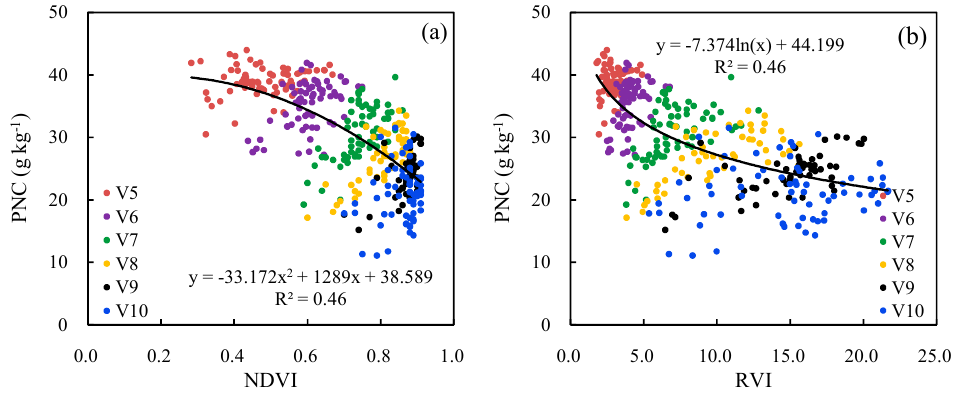
Figure 8. Relationships between plant N concentration (PNC) and GreenSeeker sensor-based normalized difference vegetation index (NDVI) ( a ) or ratio vegetation index (RVI) ( b ) across V5 to V10 growth stages in 2014 and